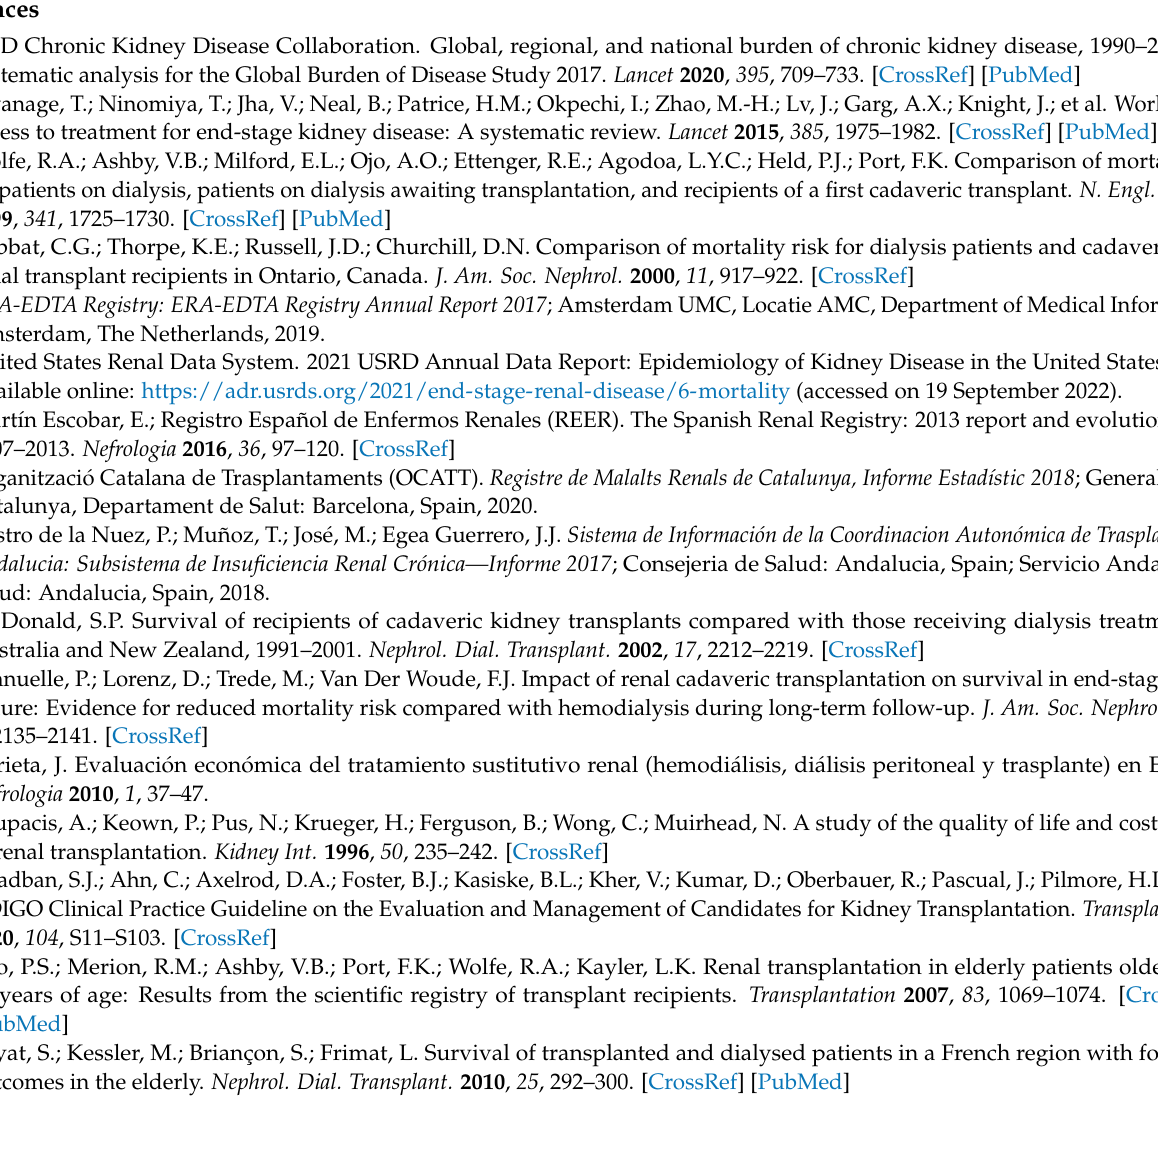
replacement therapy. Table S2: Comorbidities of patient included in the cohort of renal replacement therapy. Table S3a: Potential years of life lost in men in RRT by age group. Table S3b. Potential years of life lost in women in RRT by age